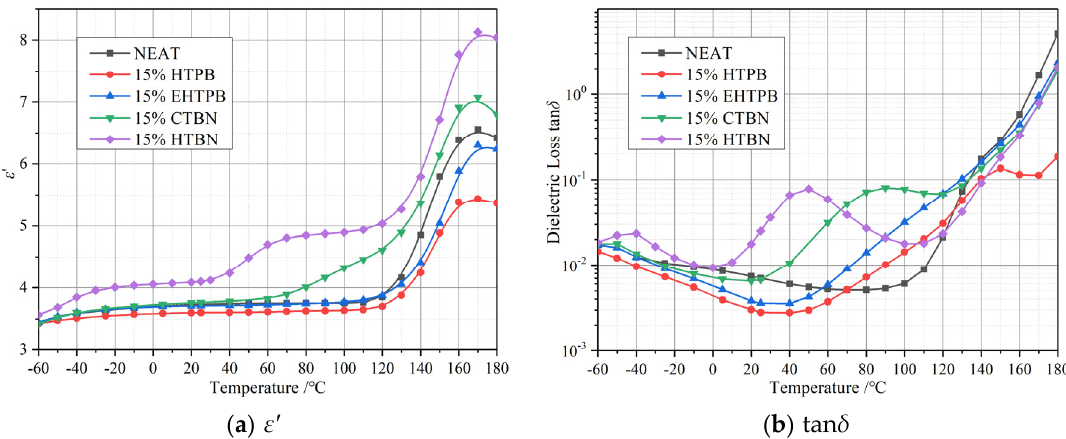
Figure 6. Temperature spectrum of epoxy resin toughened by four kinds of liquid rubber at 15% liquid rubber content (50 Hz). ( a ) ε ′ ; ( b ) tan δ . ε ′ increases with the increase of the polarity of liquid rubber. Relaxation peaks appear in the curves of tan δ due to interfacial polarization.